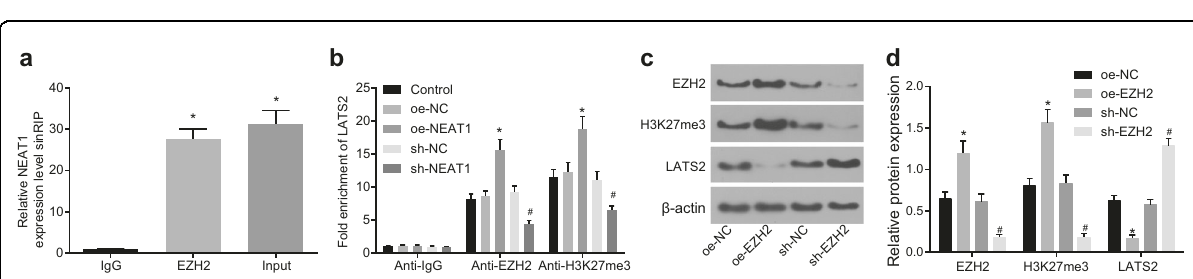
Fig. 5 LncRNA NEAT1 recruits EZH2 to the LATS2 promoter and represses LATS2 expression. The interaction between lncRNA NEAT1 and EZH2 was veri fi ed by RIP assay. * p < 0.05 vs. the IgG group ( a ). The enrichment of EZH2 and H3K27me3 on the LATS2 promoter region determined by ChIP ( b ). The protein expression patterns of EZH2, H3K27me3, and LATS2 in response to overexpression or knockdown of EZH2 measured by western blot analysis ( c ). Quanti fi cation of protein expression in c ( d ). Control group, HL-7702 cells without treatment; oe-NC group, HL-7702 cells treated with oe-NC; sh-NC group, HL-7702 cells treated with sh-NC; oe-EZH2 group, HL-7702 cells treated with oe-EZH2; sh-EZH2 group, HL-7702 cells treated with sh-EZH2. Statistical data are described as mean ± standard deviation. One-way analysis of variance was used for comparisons among multiple groups, followed by Tukey ’ s post hoc test. The experiment was repeated three times independently. lncRNA NEAT1 long noncoding RNA nuclear-enriched abundant transcript 1, LATS2 large tumor-suppressor kinase 2, EZH2 enhancer of zeste homolog 2, NC negative control, RIP RNA immunoprecipitation, ChIP chromatin